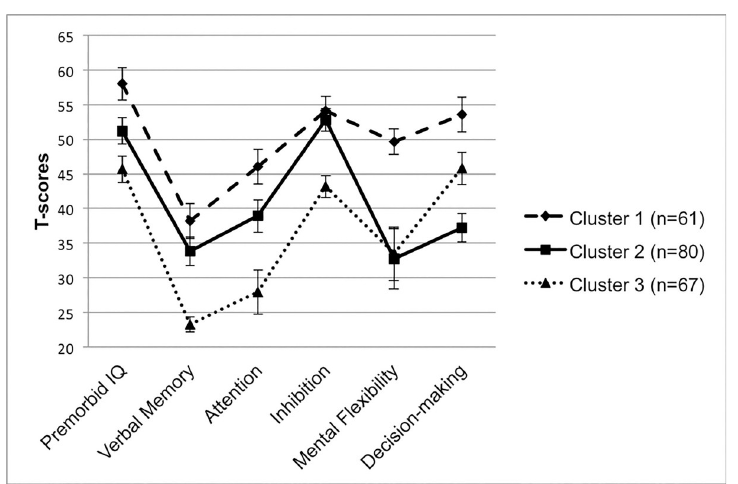
Fig 2. Demographic-adjusted neurocognitive profiles. Clusters plotted by mean neurocognitive score in T-score units corrected for age and/or education using normative test databases. Error bars represent 95% confidence